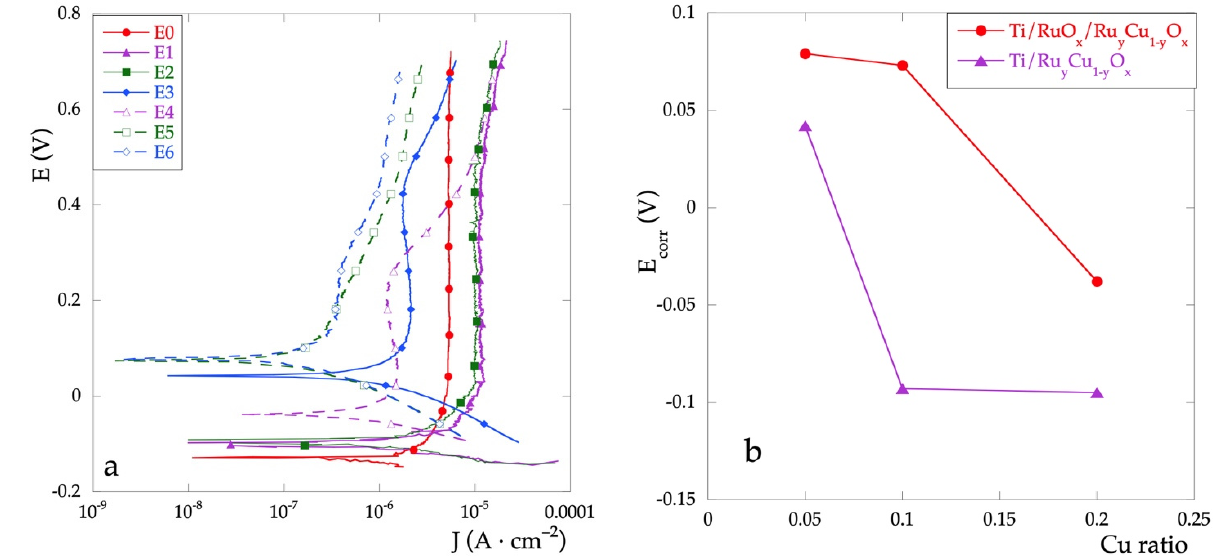
Figure 2. ( a ) polarization curves for all the electrodes in Na 2 SO 4 0.1 mol · L − 1 solution; ( b ) E corr values as a function of nominal Cu percent.